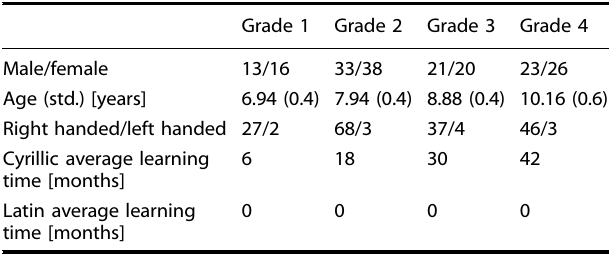
Table 3. Summary statistics for the participants involved in this